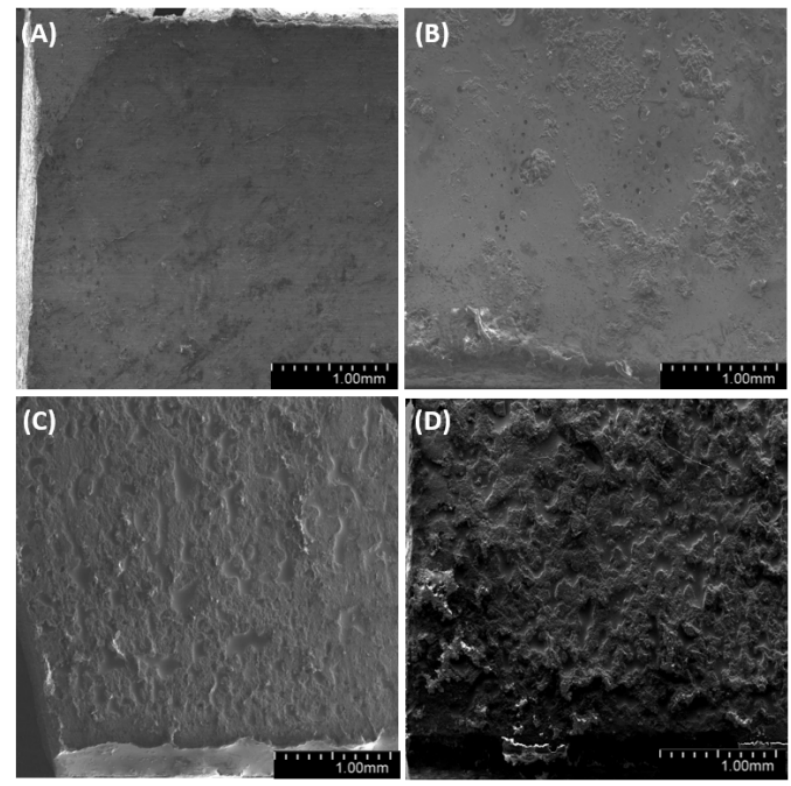
Figure 19. SEM images of the surface of samples with 36% vol. of diatoms ( A )—base deg, ( B )—base no deg, ( C )—fractionated deg, ( D )—fractionated no deg.